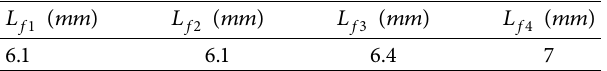
Table 6: Dimension of feed lines for design 6dB ATRD coupler has been described in Example 2.